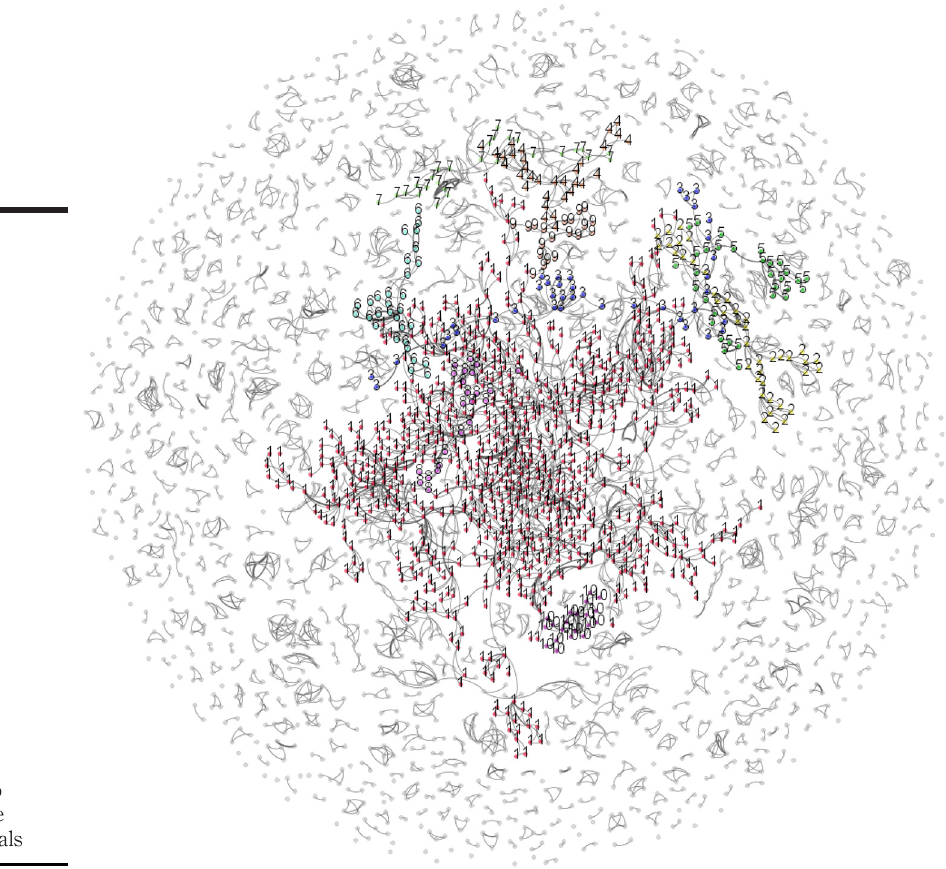
Figure 1. Co-authorship network in the selected